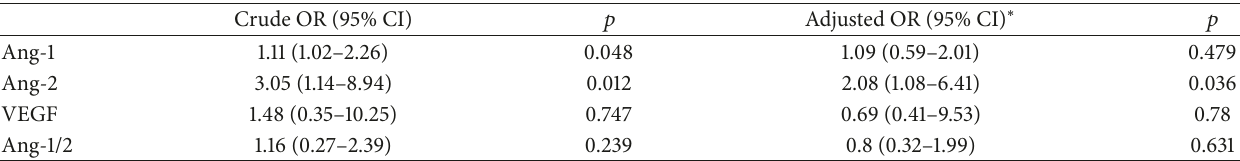
Table 4: Logistic regression models of leg pains and vascular growth factors.